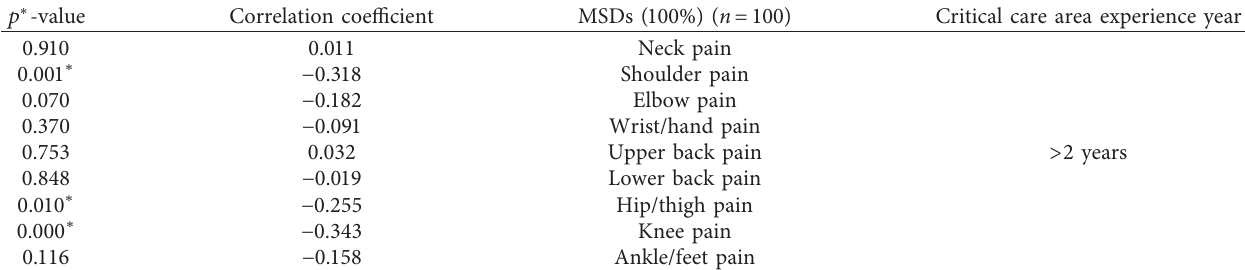
Table 4: Association of 2-year work experience at critical care unit with MSDs.